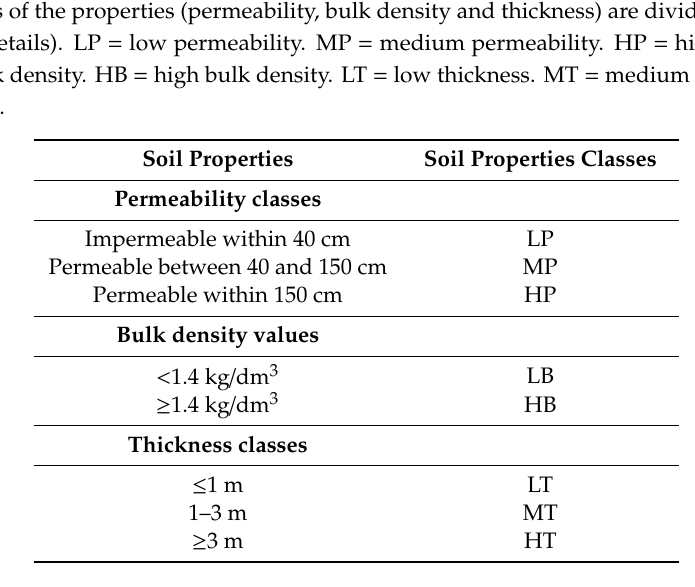
Table 3. Soil properties conditions classified in soil stability values (see text for details and previous caption for the